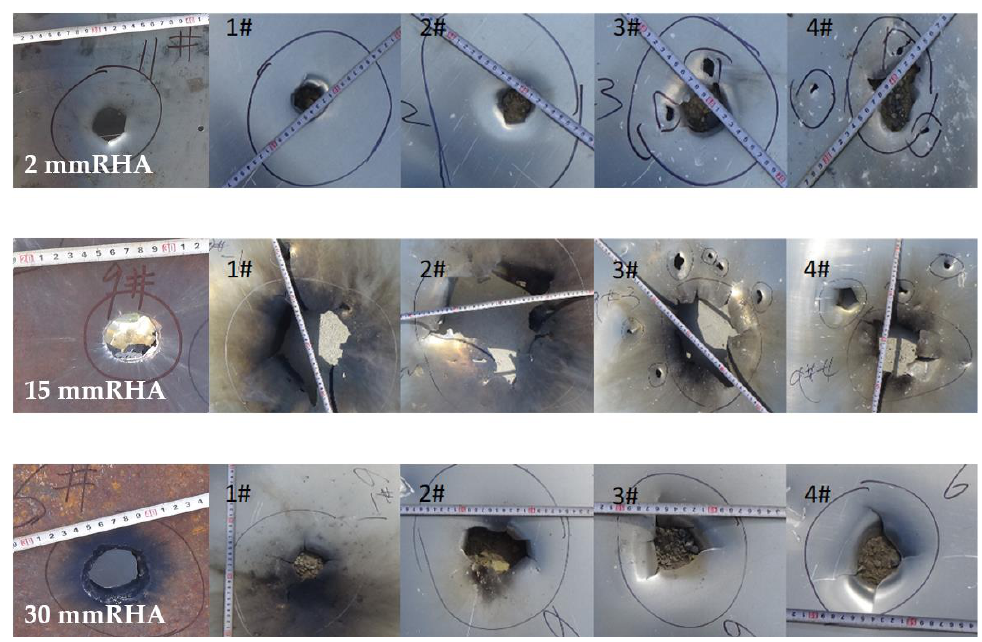
Figure 18. Damage results of MLAT with different RHA steel target thicknesses.